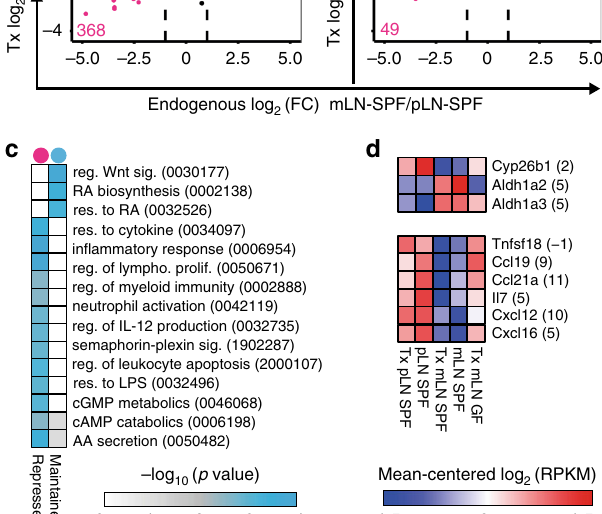
reg. of IL-12 production (0032735) semaphorin-plexin sig. (1902287) reg. of leukocyte apoptosis (2000107) res. to LPS (0032496)